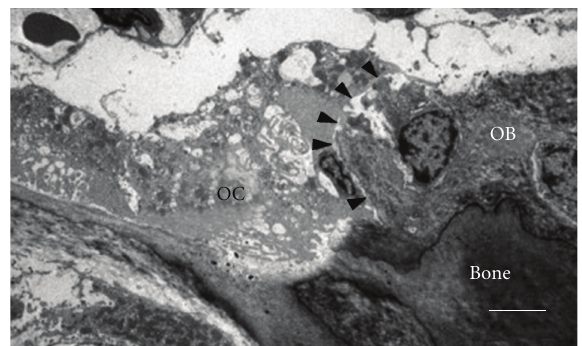
Figure 1: Transition electron micrograph of osteoclast-osteoblast contact in mouse tibial bone marrow (14-week-old male). Arrow- heads indicate a contact surface between osteoclasts (OC) and osteoblasts (OB). Scale bar, 5 μ m